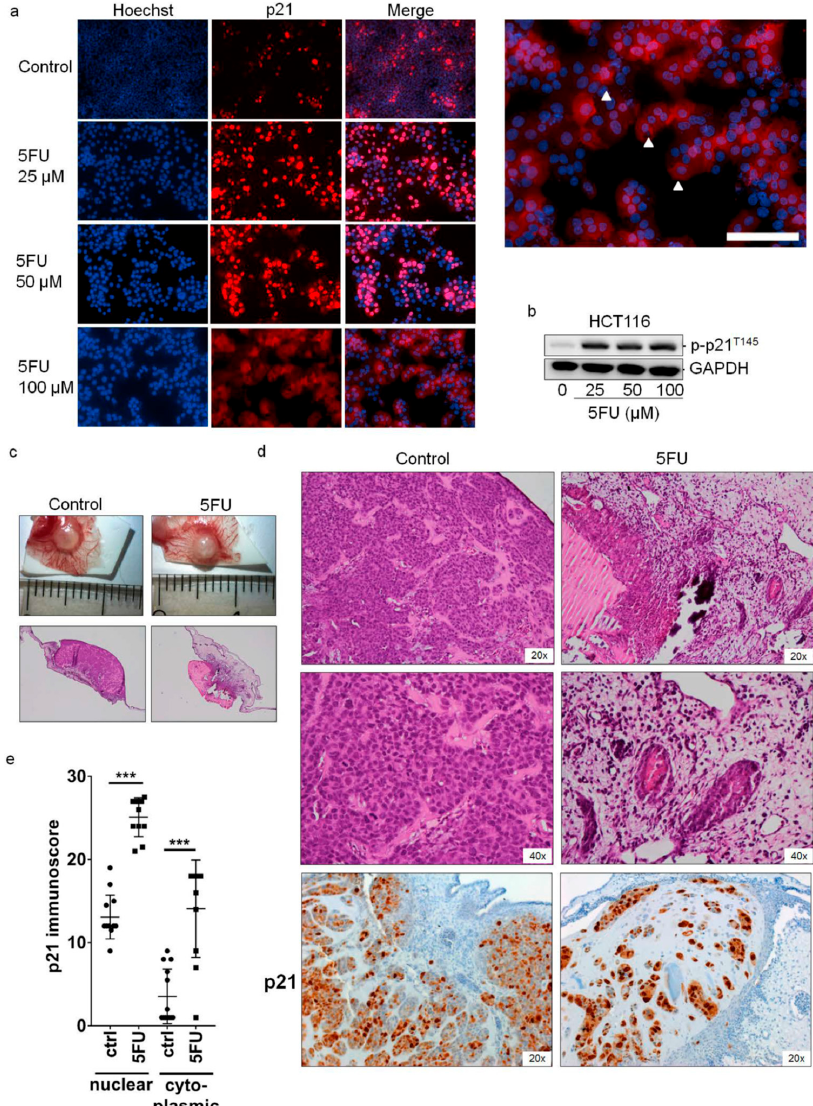
Figure 2. Localization of p21 in 5FU - resistant HCT116 cells. ( a ) HCT116 cells were treated with various concentrations of 5FU for 48 h and the expression of p21 was determined by immunofluorescence staining using mouse anti - p21 monoclonal antibodies followed by an Alexa Fluor 555 - labeled secondary antibody to visualize p21 expression (red) and the nuclei (Hoechst 33342, blue ) . Scale bar: 50 μ m. ( b ) The expression level of phosphorylated-p21 (p - p21 T145 ) in 5FU - resistant HCT116 cells was determined by Western Blot analysis . Cells were treated with various concentrations of 5FU for 48 h . After incubation, dead cells were discarded by washing the plates 3 times with PBS and the remaining resistant cells were collected to prepare protein lysates as mentioned in the Material and Methods section . The blots were re - probed with GAPDH to confirm equal loading of the samples . ( c ) Ex ovo images and overviews of H&E-stained sections of CAM micro-tumors . For this, HCT116 cells were treated with 15 μ M of 5FU for 48 h. Then the 5FU-resistant HCT116 cells were subjected to the CAM. After 5 days, tumor tissues were collected, tumor size was measured, and xenografts were subjected to standard histological and immunohistochemical procedures. ( d ) H&E staining and immunohistochemical staining of p21 protein in vital areas of tumor slices. ( e ) Immunoscore of p21 regarding its cytoplasmic and nuclear localization in xenografts of 5FU-treated HCT116 and control cells. *** p < 0 . 001 versus non - treated control.